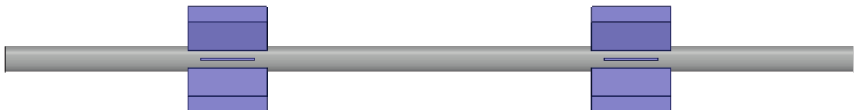
Figure 17: The layout of Example 2.